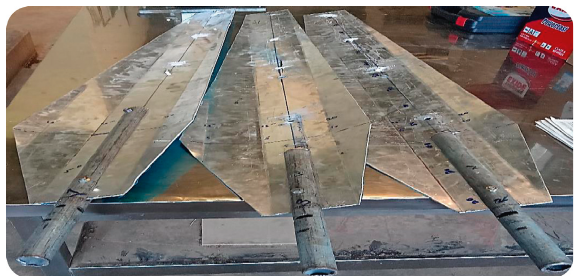
Figure 2: Fabricated aluminium